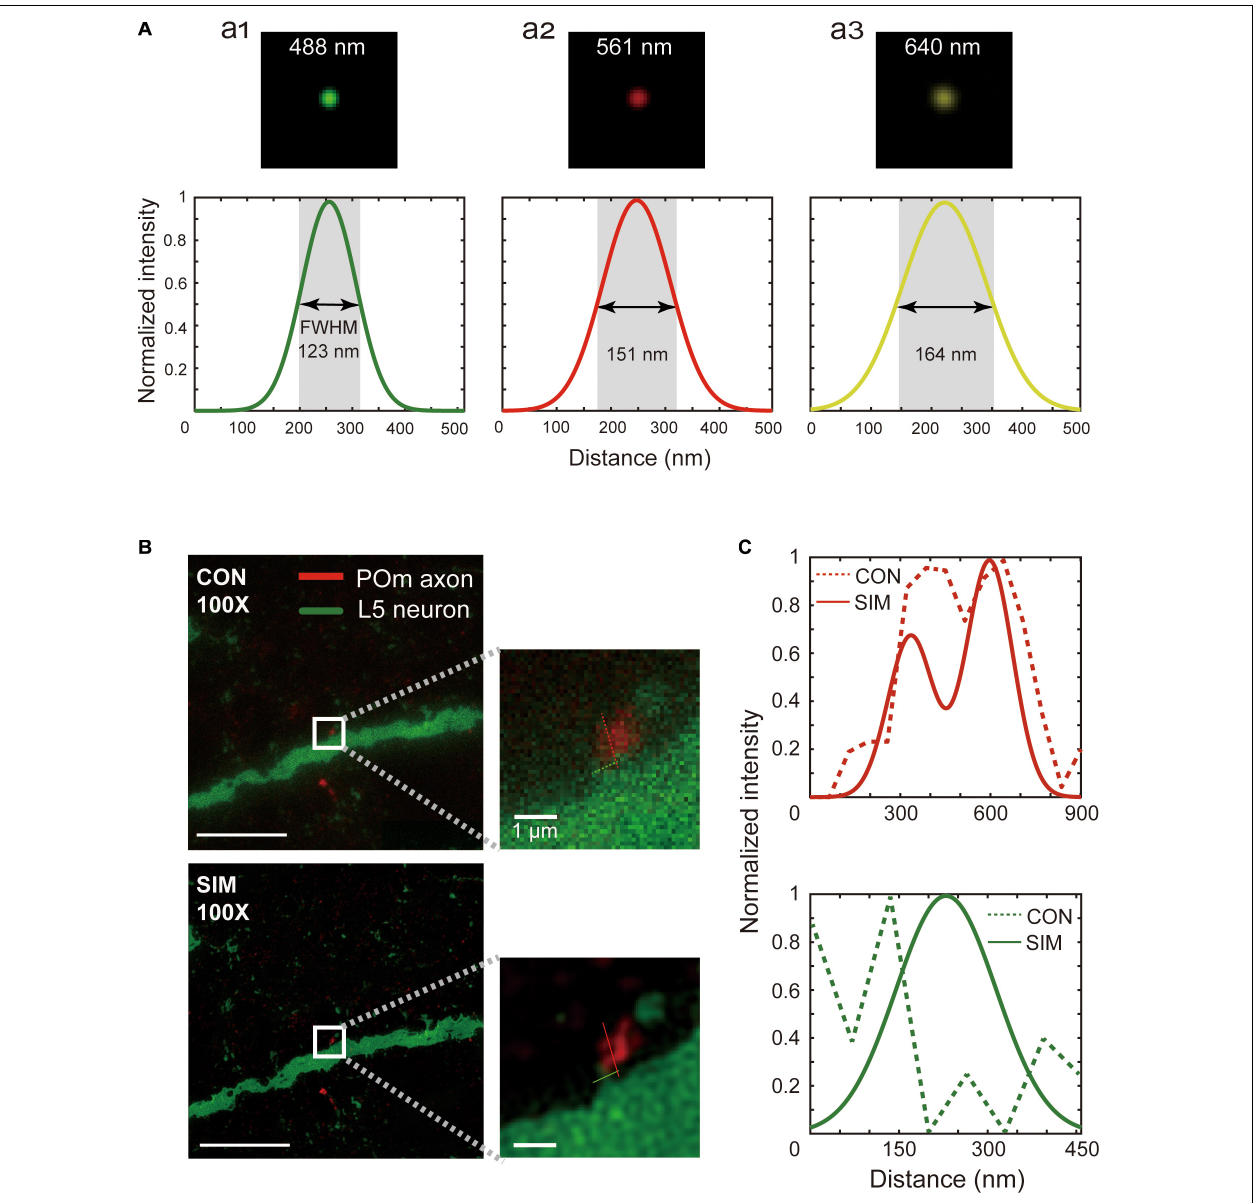
FIGURE 3 | Spatial resolution of SIM images. (A) Point spread function measured with the excitation wavelengths used for SIM imaging, 488 nm (a 1 ), 561 nm (a 2 ), and 640 nm (a 3 ). The full width half maximum of a fluorescent bead was measured at these wavelengths. (B) A relatively small pre- and postsynaptic structure image acquired by conventional microscopy (upper) and SIM (below), and a zoomed-in view (white box, inset). Scale bars represent 10 µ m (left) and 1 µ m (inset). (C) Pixel intensity plots along the red and green lines shown in the magnified images of conventional (dotted) and SIM (solid)